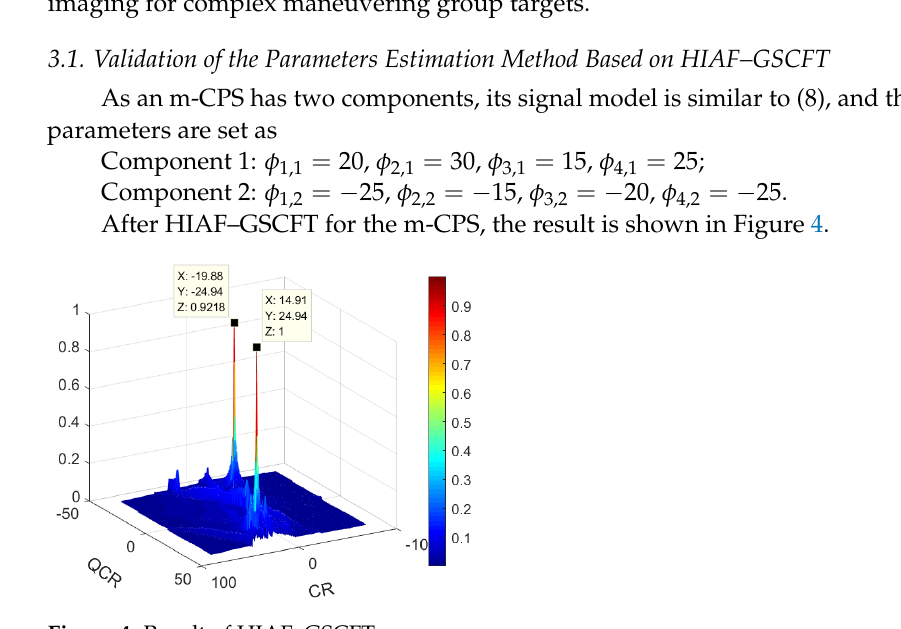
Figure 4. Result of HIAF–GSCFT.